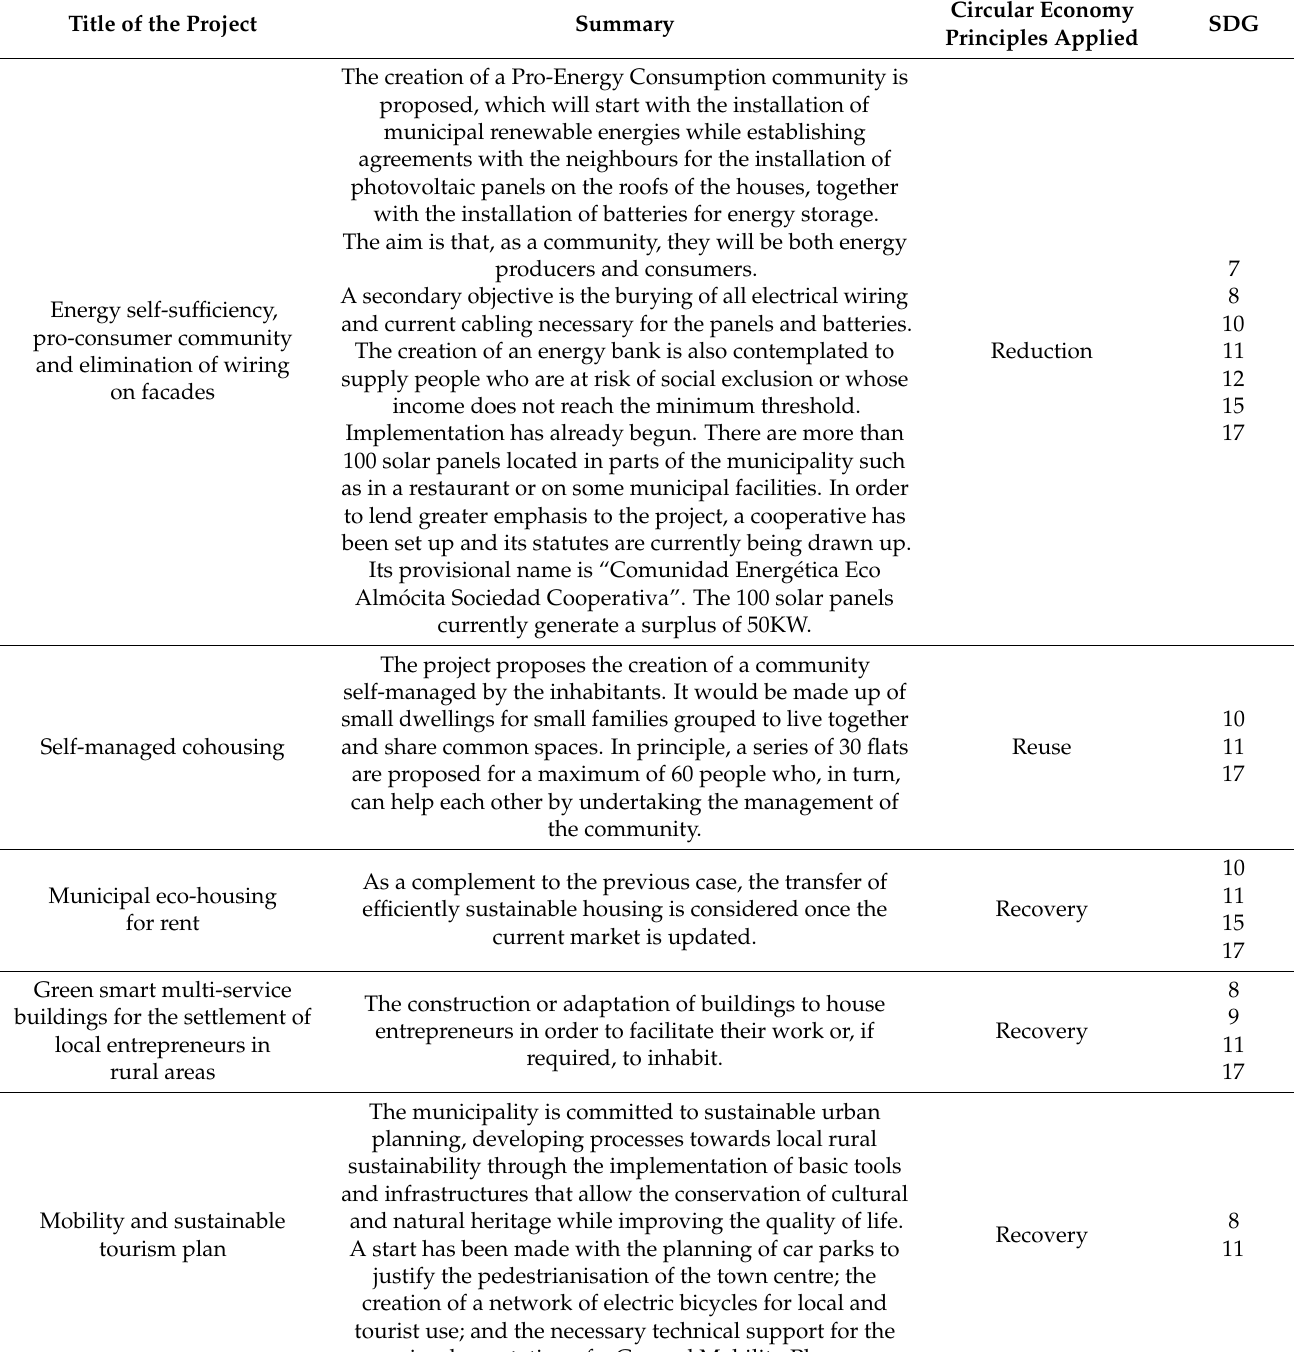
Table 4. Projects to be implemented from 2020 onwards with the “Alm ó cita in Transition”